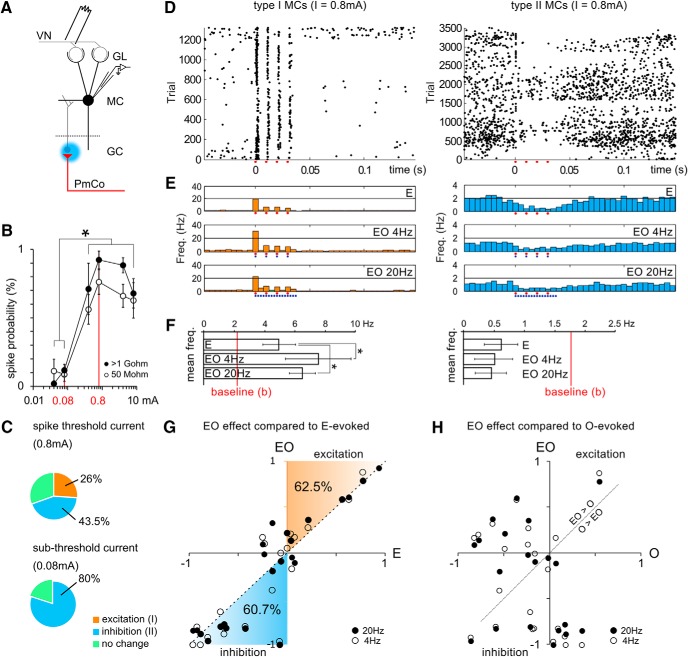
PmCo feedback enhances MC responses to vomeronasal inputs. A, Diagram showing the configuration used during recordings: electrical stimuli were targeted onto the VN, light stimuli were delivered onto the GC layer, and the firing rate of MCs was recorded in cell-attached mode. B, Tuning curves of MCs in response to current stimuli of different intensity were obtained at different seal resistance levels: 1 GΩ, black dots; 50 MΩ, circles. This preliminary test was made to define the threshold current for MC firing, used in the rest of the experiments (2-way ANOVA, p = 0.004). C, Percentage of the different types of MC responses following electrical VN stimulations above (0.8 mA) and below (0.08 mA) threshold. D, Raster plots of type I and type II MC activity during electrode stimulation (red dots). E, Average firing rate (across units and trials) of MCs divided by type (I or II) and stimulation. EO 4 Hz/EO 20 Hz (joint electrical and optical stimulation at 4 and 20 Hz, respectively. Red dots mark electrical stimuli; blue dots mark optical stimuli. F, Mean firing rate changes induced in MCs by optogenetic activation of PmCo feedback. The red lines represent the firing frequency at unstimulated baseline levels. G, Relative increase and decrease in firing rates during joint electrical and optical stimulation (y-axis) and electrical only stimulation (x-axis) both referred to baseline levels. Firing rate was computed during 40 ms of stimulation. H, Two LED stimulation protocols are color coded in darker (EO 20 Hz) or lighter (EO 4 Hz) red (for excitation) or blue (for inhibition). Percentage values refer to either values of E > 0 or E < 0). Scatter plot showing the lack of correlation between the relative effect of dual electrical and light stimulations on light-evoked responses alone. Data are the mean ± SEM.